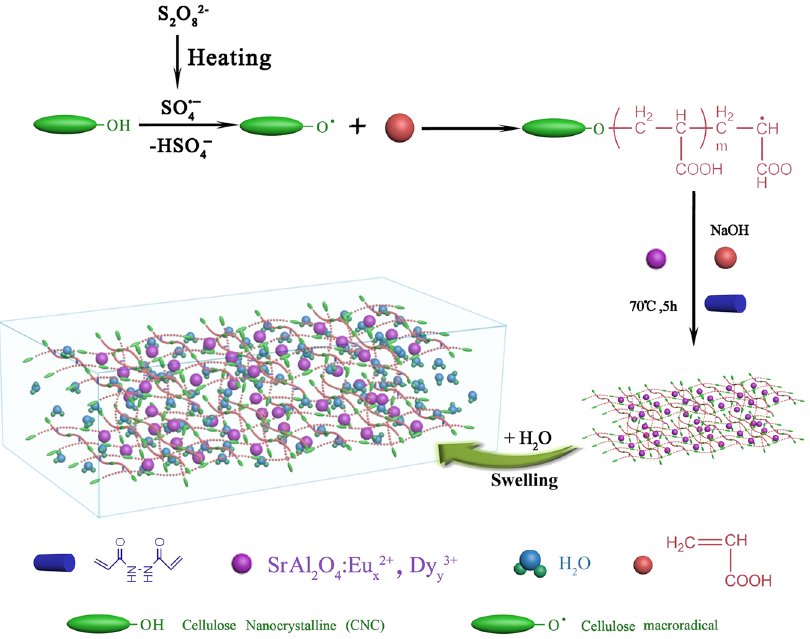
Figure 7. Schematic diagram of the synthesis of the nano-hybrid